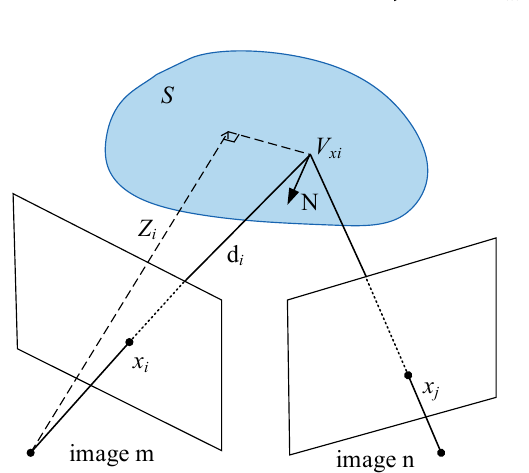
Figure 4. Diagram of the resolution between image point and object point.